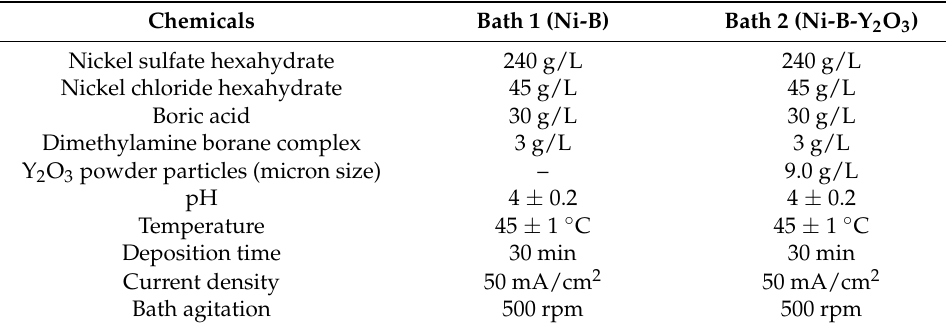
Table 1. Coating bath composition and operating